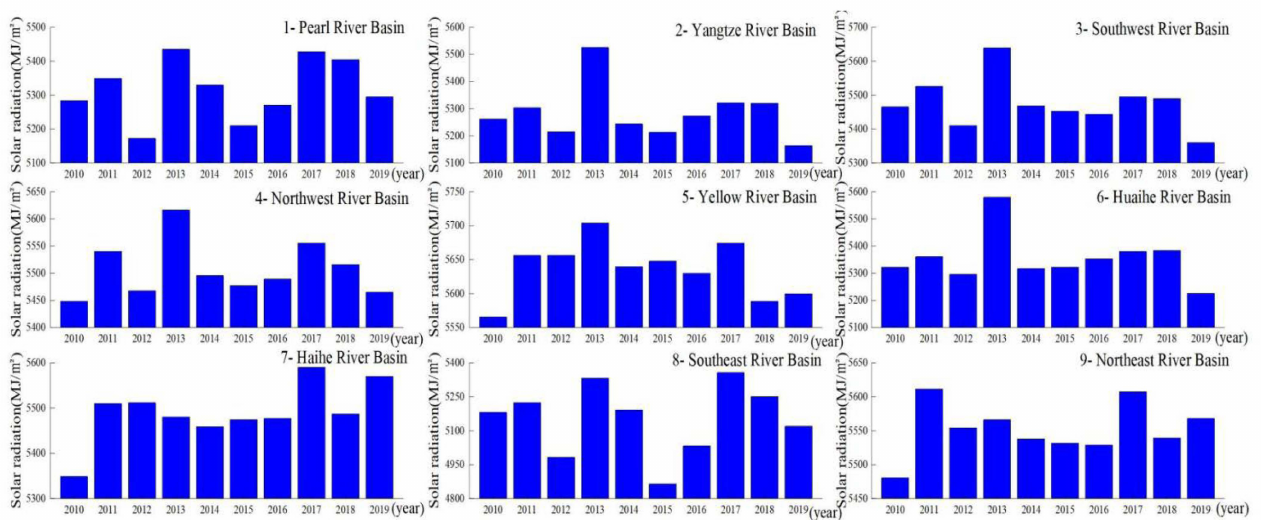
Figure 4. Interannual variation in annual surface solar radiation in nine river basins of China from 2010 to